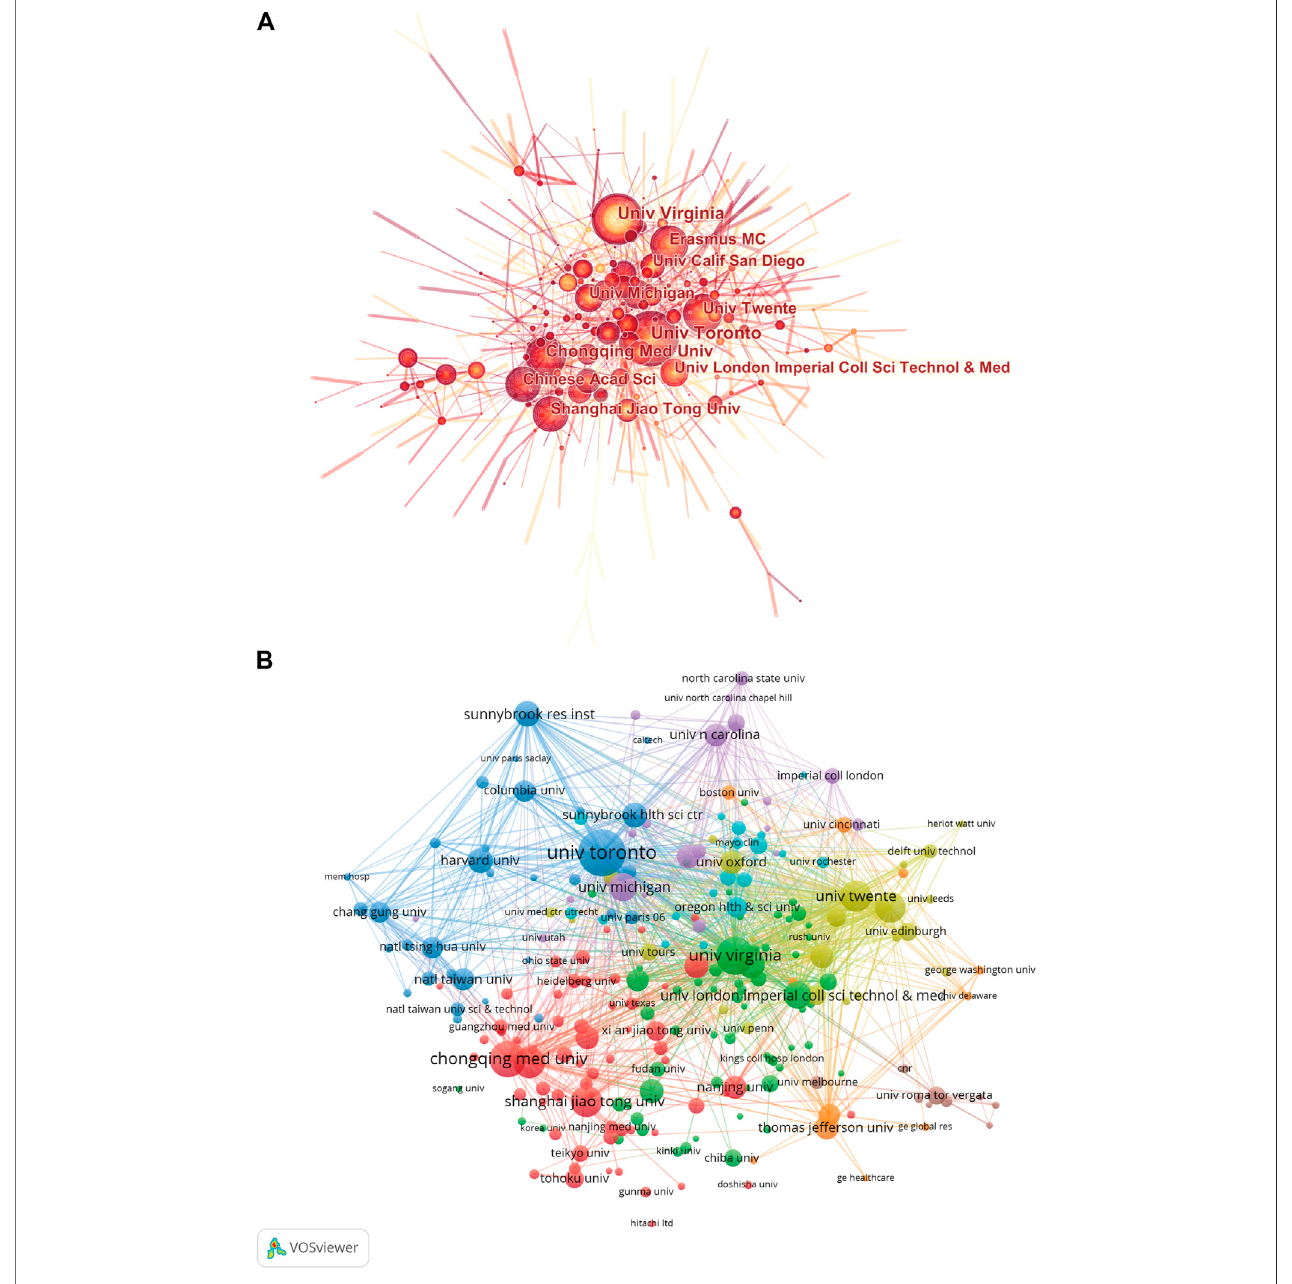
FIGURE 5 | (A) Network map of institution coauthorship analysis based on CiteSpace. In the visualization map, each node represents an institution, and its size is proportionaltothenumberofpublications.Linksbetweennodesrepresentthestrengthofcollaborations. (B) Mappingofthecitationanalysisamong238identi fi edinstitutionson ultrasound microbubble research based on the VOS viewer. The explanation of the nodes and links in the map is identical to that described in Figure 4B above.